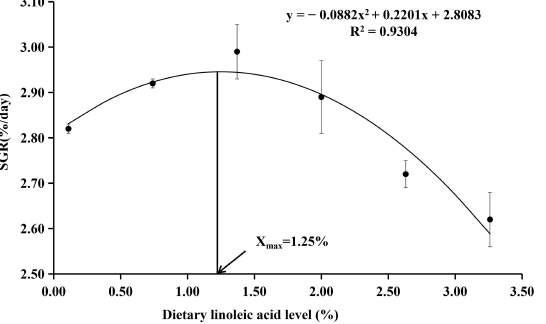
Figure 1. Quadratic regression analysis of SGR with dietary linoleic acid (LA) levels in coho salmon Oncorhynchus kisutch alevins. Estimated dietary LA requirement of SGR is 1.25%. Each point repre- sents the mean of three